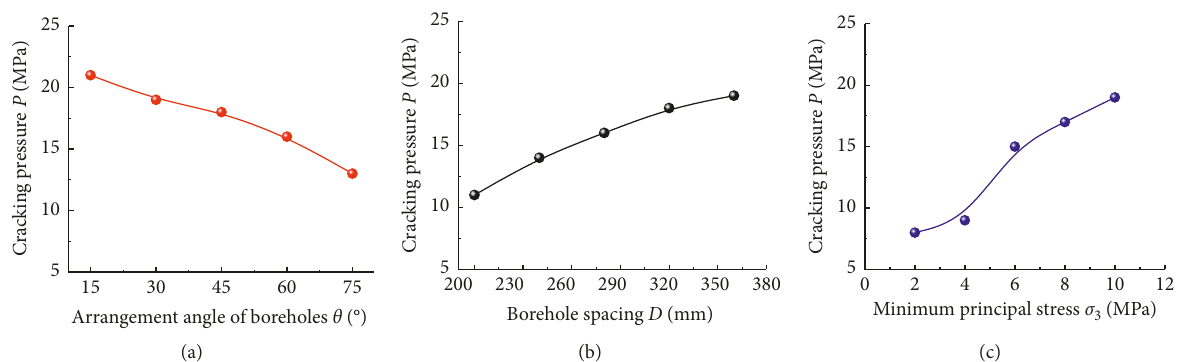
Figure 9: Fracture water pressure under different influencing factors. (a) Angle θ between borehole direction and σ D . (c) Minimum principal stress σ 3 .